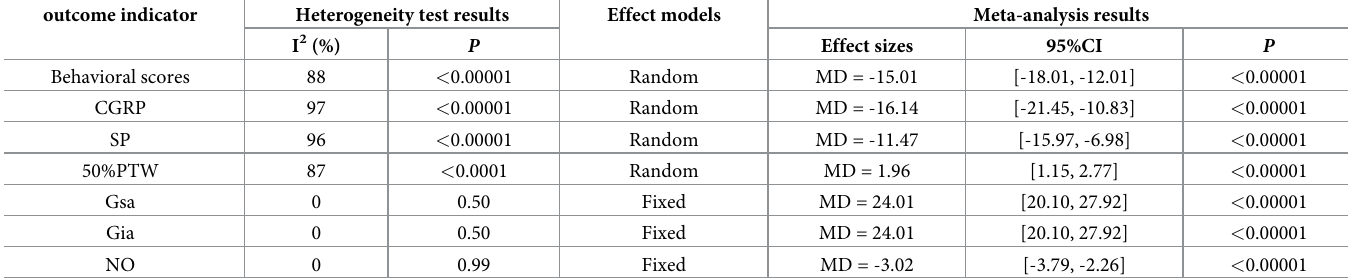
Table 3. Meta-analysis results of each outcome